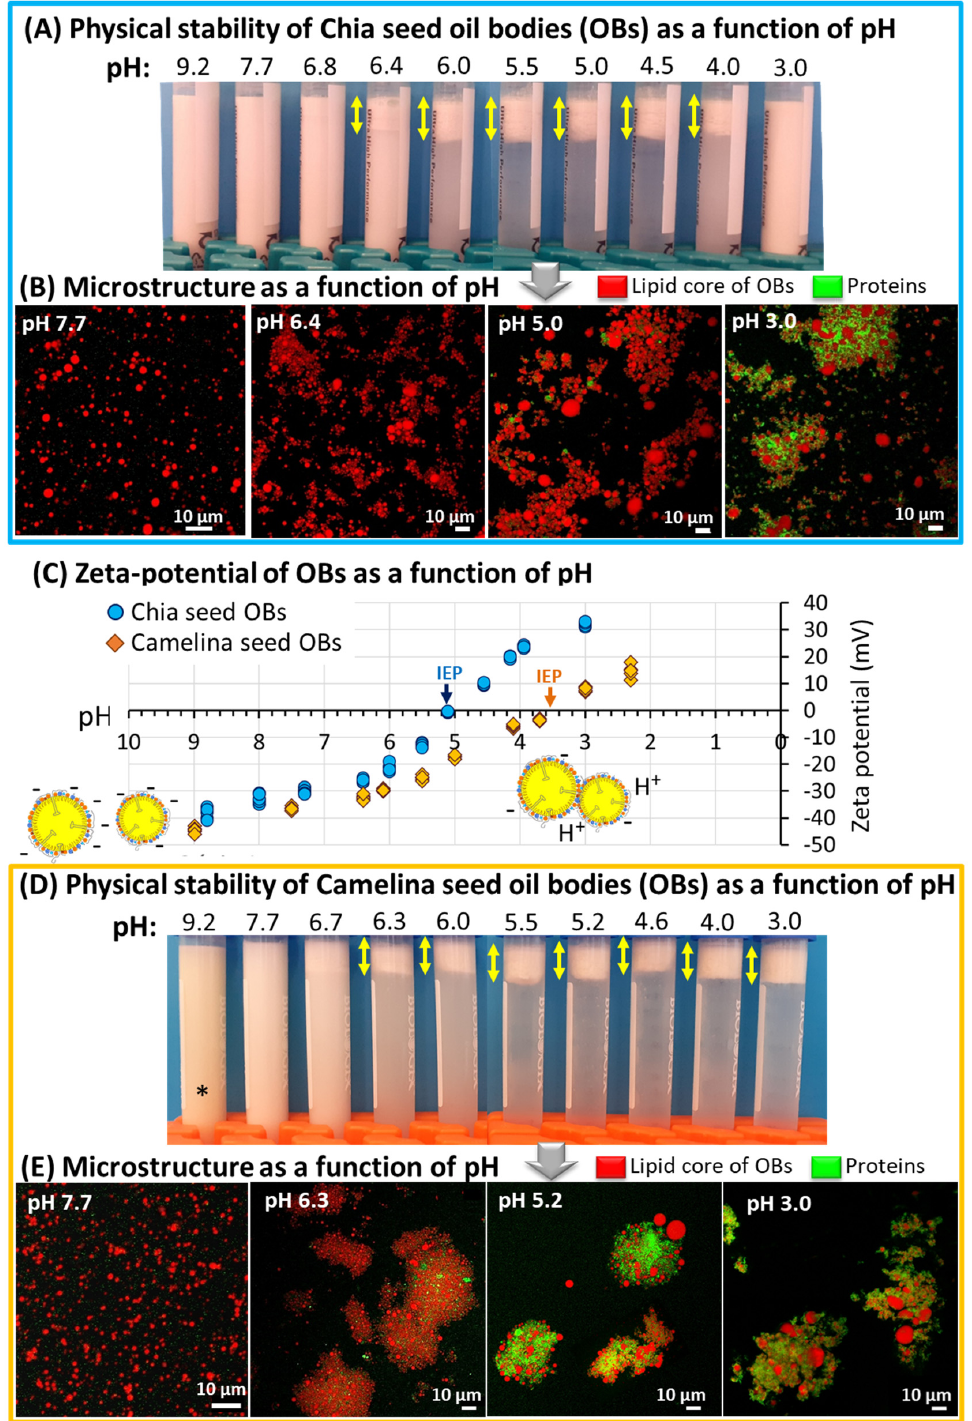
Figure 8. Effect of pH on natural oil-in-water emulsions composed of chia and camelina seed oil bodies (OBs). ( A , D ) Physical stability of the emulsions as a function of pH observed at the macroscopic level; (*) indicates the browning of camelina seed aqueous extract at basic pH due to the presence of rutin. ( B,E ) Confocal laser scanning microscopy (CLSM) images of the emulsions as a function of pH, the cores of the OBs were stained with Nile red (red colour) and the proteins with Fast Green FCF (green colour) fluorescent dyes. The scale bars are indicated in the figures. ( C ) Zeta- potential of the OBs as a function of pH; illustrations of OBs exhibiting electrostatic repulsions at pH 9 and aggregation near the isoelectric point (IEP).